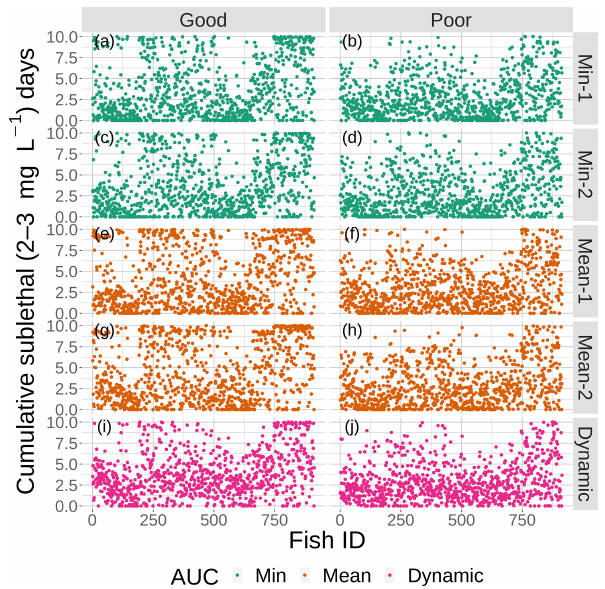
Figure 12. The percentage of fish exposed to DO of 2–3mgL − 1 for good (a) and poor (b) competency for the four snapshot maps with high sublethal area and the dynamic version. Maps within the same AUC category (“Min”) are shown with the same